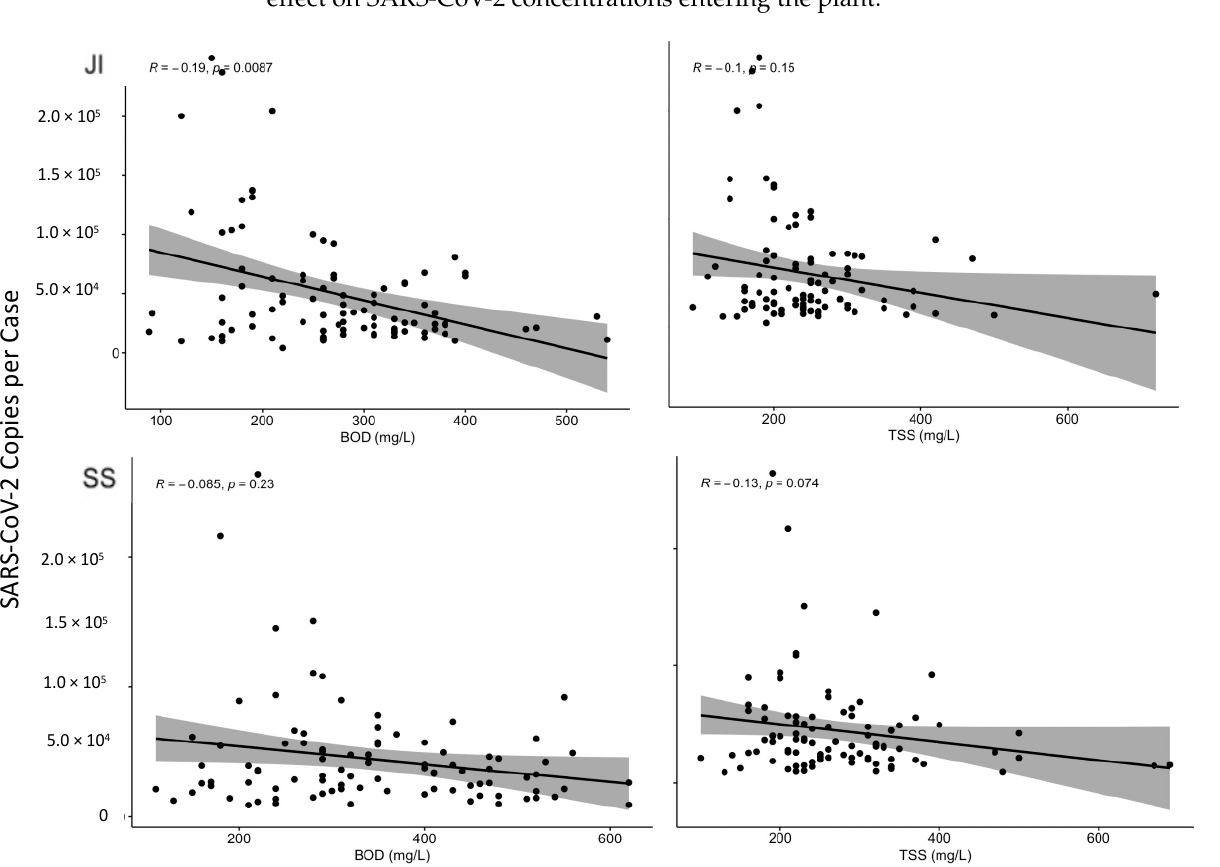
Figure 6. Kendall’s rank correlation of BOD (mg/L), and TSS (mg/L) to SARS-CoV-2 copies per case in JI (top) and SS (bottom) WWTPs.